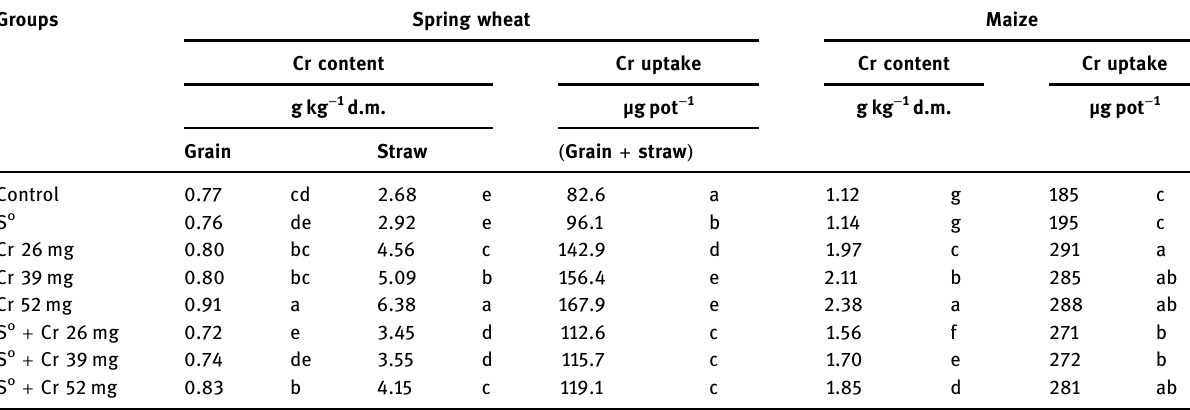
Table 5: Chromium content and uptake in cultivated plants Groups Spring